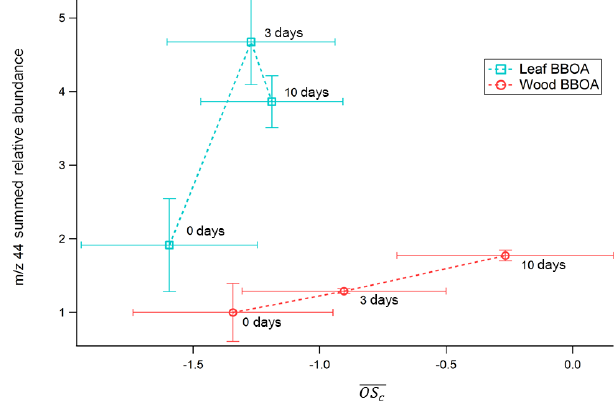
Figure 7. TAG decomposition m/z 44 integrated relative abun- dances for PAM-aged leaf and heartwood BBOA as functions of AMS OS C . Here, all TAG data have been normalized to the unaged (“0 days”) wood BBOA integrated m/z 44